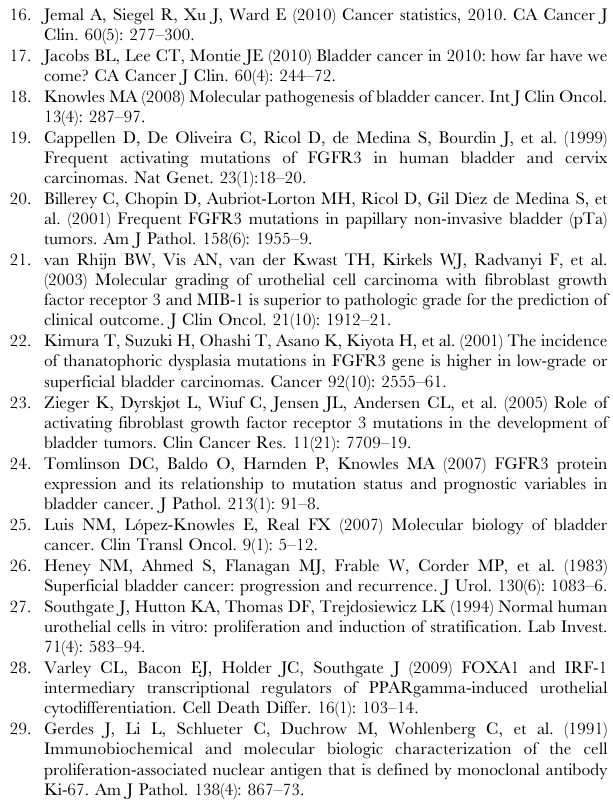
that pass the above thresholds are highlighted (red for up- regulation and green for down-regulation). Table S4 Genes significantly up- or down-regulated in each Rab cluster for each tumor group of the two pathways. ‘‘D’’ (green) corresponds to a gene significantly down- regulated in the tumor samples, ‘‘U’’ (red) corresponds to a gene significantly up-regulated in the tumor samples. ‘‘% All genes’’ corresponds to the total number of genes up- or down-regulated within each tumor group. A binomial test was applied for each Rab cluster within each tumor group. The binomial test pValues , 1% are highlighted in orange. ‘‘Absent’’ corresponds to a gene absent in the Affymetrix HG U133 Plus 2.0 DNA microarrays. Table S5 Pearson correlation (r) (and pValue) between the expression of MKI67 and the expression of genes listed in left column. Pearson correlation (r) (and pValue) between the expression of MKI67 and the expression of genes listed in left column in 28 Ta G1G2 ( FGFR3 -mutated) tumor samples and 63 T2-4 ( FGFR3 -non-mutated) tumor samples. Are highlighted (in green or red) when |r| . 0.479 for the Ta G1G2 ( FGFR3 -mutated) group (28 samples) and |r| . 0.323 for the T2–4 ( FGFR3 -non-mutated) group (63 samples). Table S6 Pearson correlation (r) (and pValue) between the expression of different urothelial differentiation markers genes and the expression of genes listed in left column. Pearson correlation (r) (and pValue) between the expression of FOXA1 , GRHL3 , UPK1A/B , UPK2 , UPK3A/B and the expression of genes listed in left column in 28 Ta G1/G2